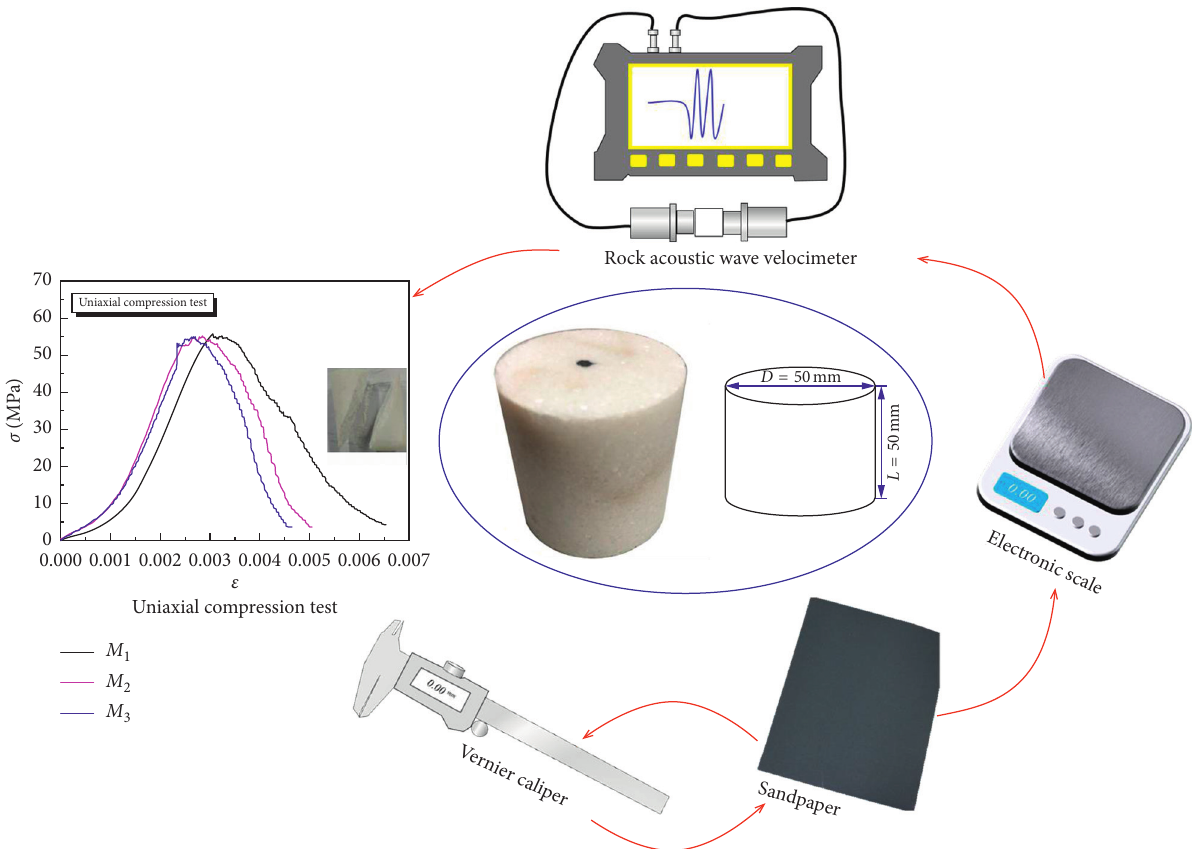
Figure 2: Marble sample processing